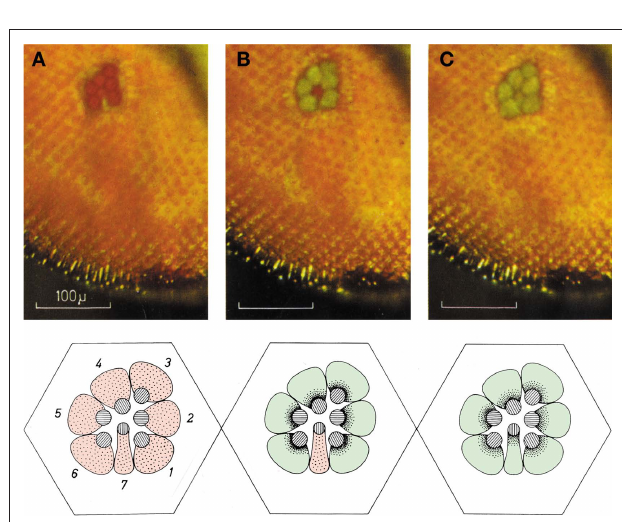
FIGURE 3 | Deep pseudopupil (dpp) observed in the eye of a living Drosophila under white orthodromic illumination. The dpp is the superposition of virtual images of adjacent ommatidia observed when a low power microscope is focused at the center of the curvature of the compound eye of Diptera . (A) Dark adapted. (B) After 60 s of medium intense illumination. Note that the central image corresponding to R7/R8 still appears red while the six peripheral images corresponding to R1–R6 refl ect green light. (C) After 60 s of intense illumination (twofold higher). Note that all images refl ect green light. The disparity between (B) and (C) arises from the difference in the absorption spectra between rhodopsin expressed in R1–R6 compared to R7 (upper panels). Schematic representation of the positioning of the pigment granules at each of the above states (lower panels) (modifi ed from Franceschini and Kirschfeld,